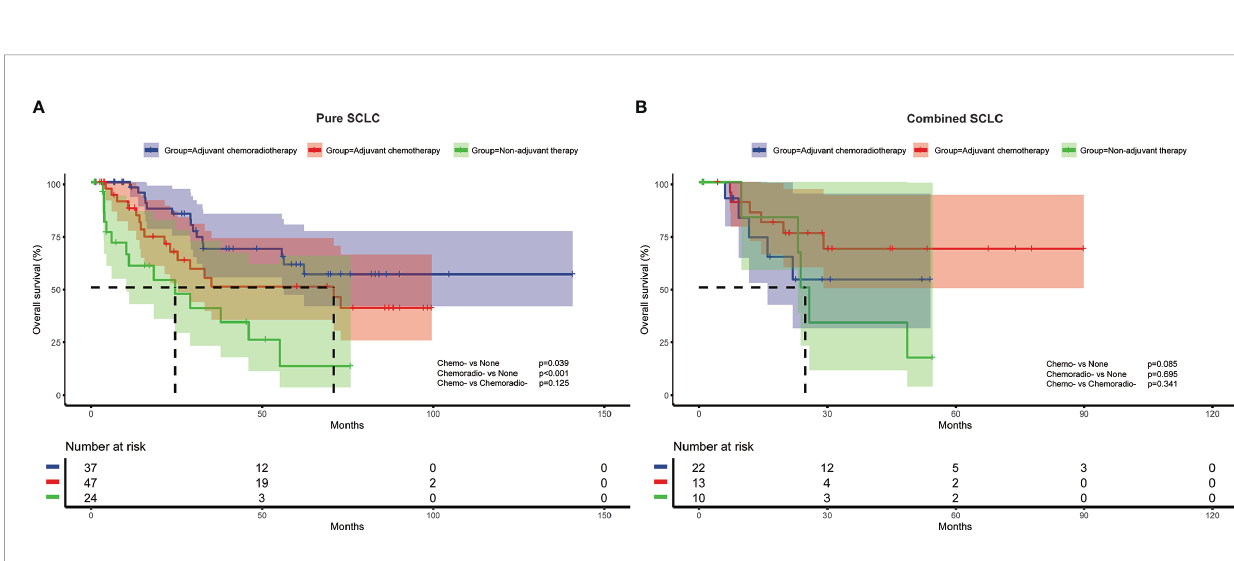
Frontiers in Oncology |